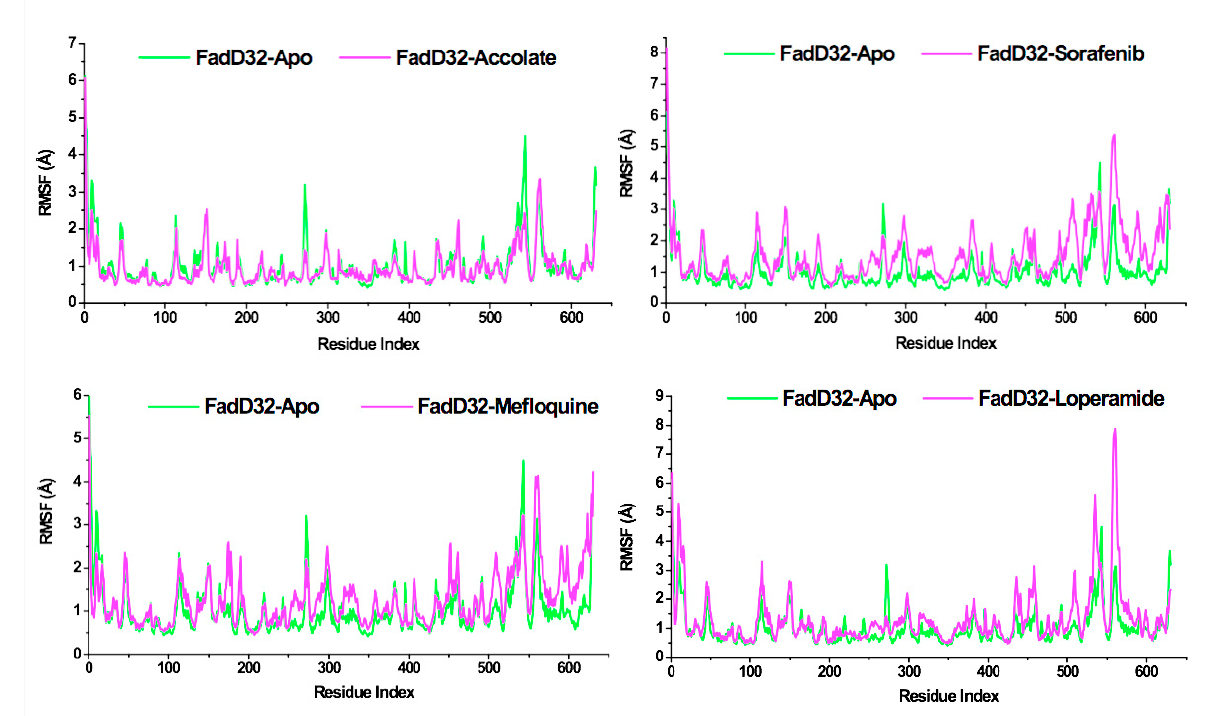
Figure 6. RMSF Plot of FadD32-Apo, FadD32-Accolate, FadD32-Sorafenib, FadD32-Mefloquine, and FadD32-Loperamide.